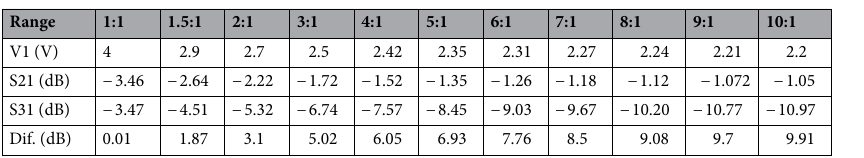
Table 1. Important ranges of divided power for second design TWPD at V2 =